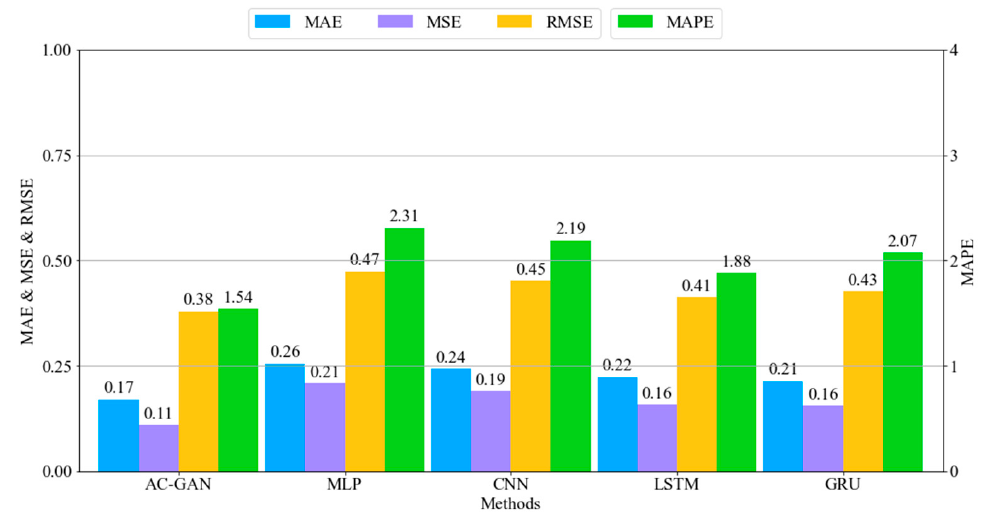
Figure 13. Error rates of casting process models.